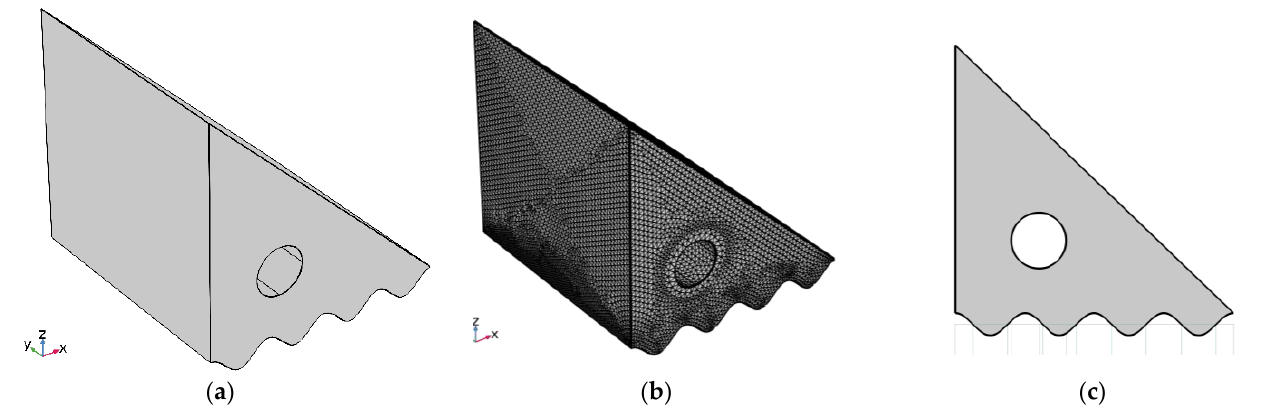
Figure 1. The computational domain ( a ) 3D view of the chamber, ( b ) 2D view of the geometry and ( c ) grid mesh.